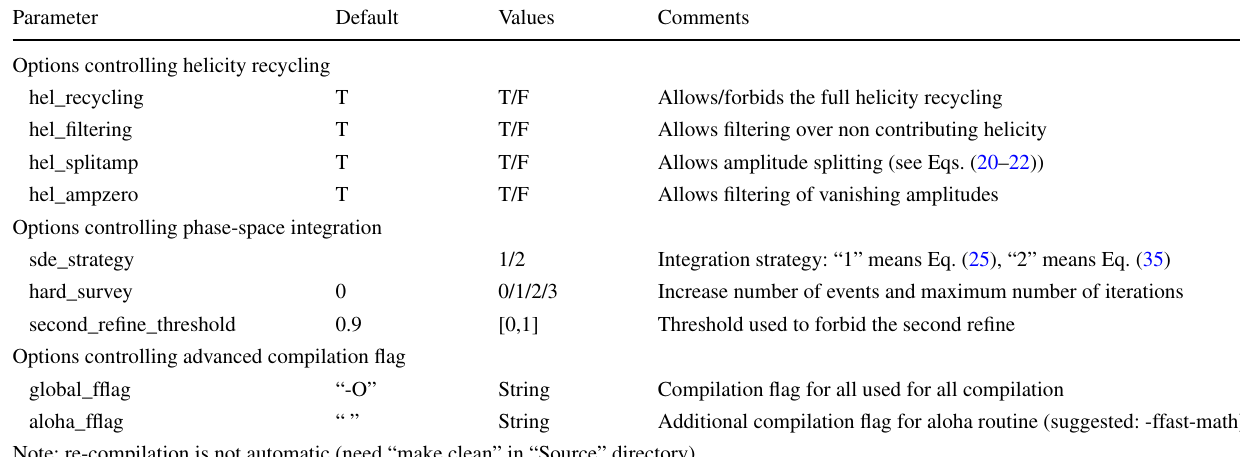
Table 8 Short description of the various hidden parameters that can be specified within the run_card (configuration file) to tweak the behaviour of the new methods introduced in this